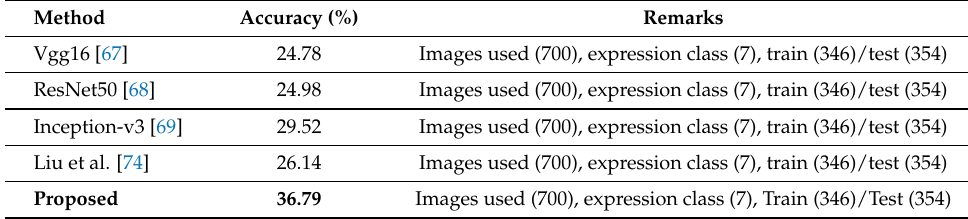
Table 10. Performance comparison of the proposed FERS for the SFEW